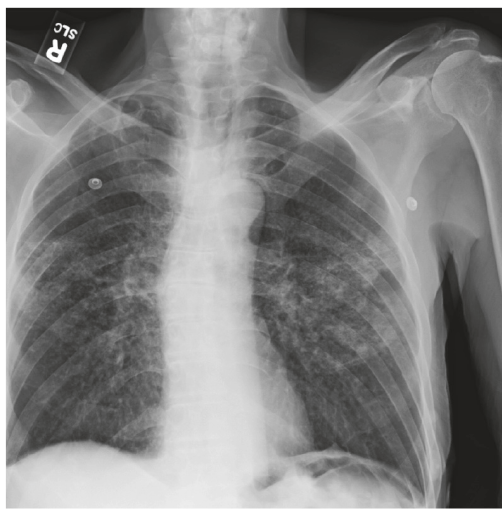
Figure 1: Posteroanterior chest X-ray demonstrating extensive ill- defined bilateral parenchymal opacities in the perihilar, mid, and lower lung